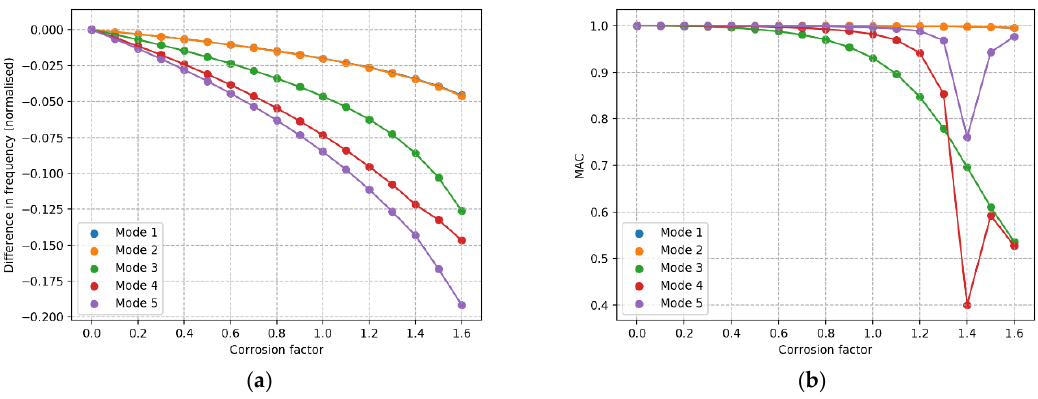
Figure 16. Effect of corrosion relative to the uncorroded structure. ( a ) Change in frequency, ( b ) MAC values.